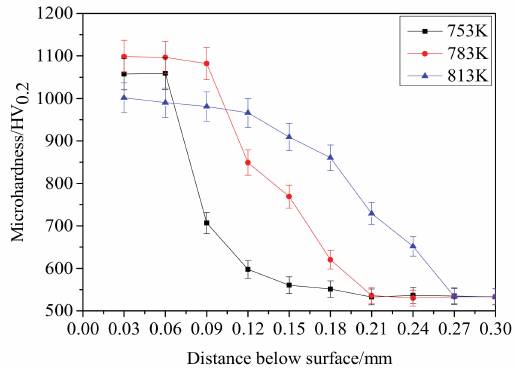
Figure 6. Microhardness distribution of the plasma-nitrided